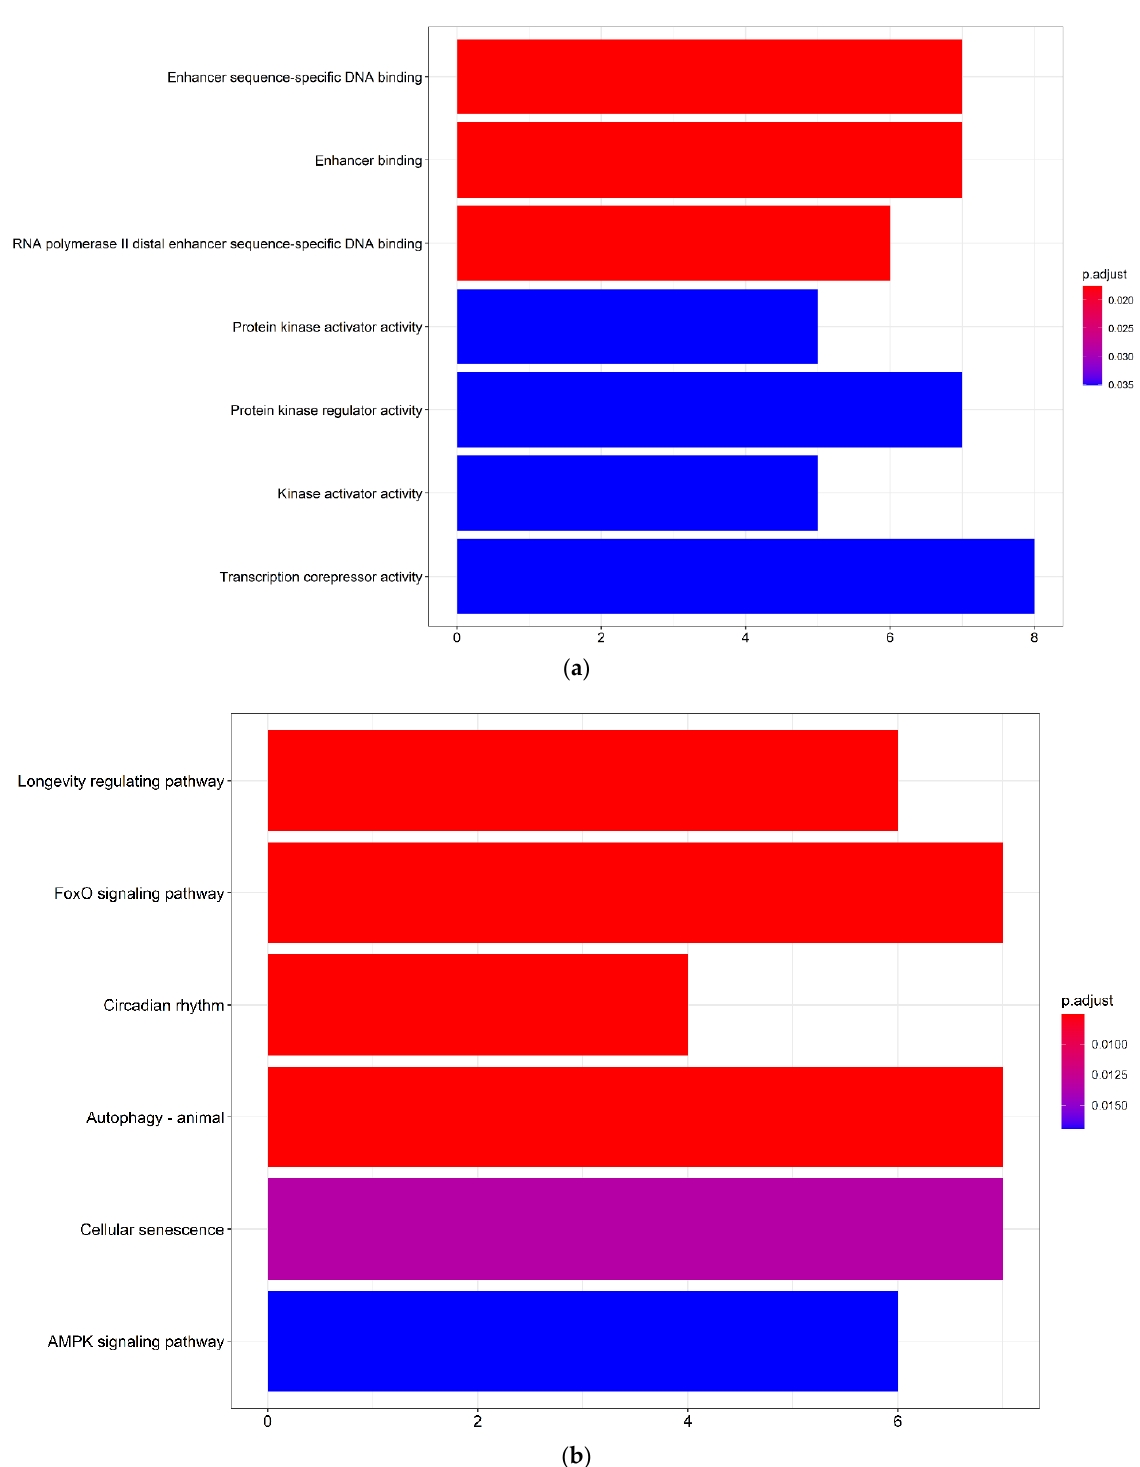
Figure 3. Bar chart of the GO and KEGG analysis of DEmRNAs in the ceRNA network. ( a ) Bar chart of the significant GO terms with DEmRNAs identified by the clusterProfiler package in R. The color of the bar represents the −log 10 transformed p values of the GO terms and the abscissa corresponds with the number of genes in the GO terms; ( b ) bar chart of significant KEGG enriched pathways with DEmRNAs identified by the clusterProfiler package in R. The color of the bar represents the −log10 transformed p values of the KEGG enriched pathways and the abscissa corresponds with the number of genes in the KEGG enriched pathways. GO: Gene Ontology; KEGG: Kyoto Encyclopedia of Genes and Genomes; DElncRNAs: differentially expressed lncRNAs; DEmRNAs: differentially expressed